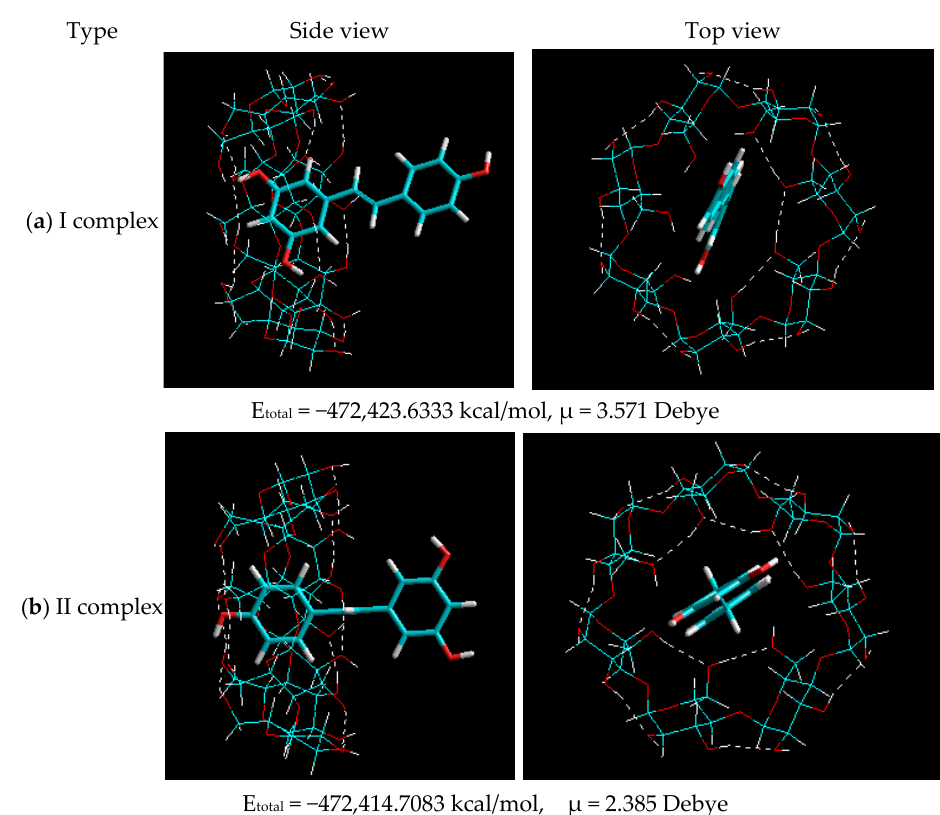
Figure 4. Optimized structure of the type I β -CD – resveratrol complex at a ratio of 1:1 (inclusion of aromatic ring A ( a ) and aromatic ring B ( b )). Dotted lines show hydrogen bonds.